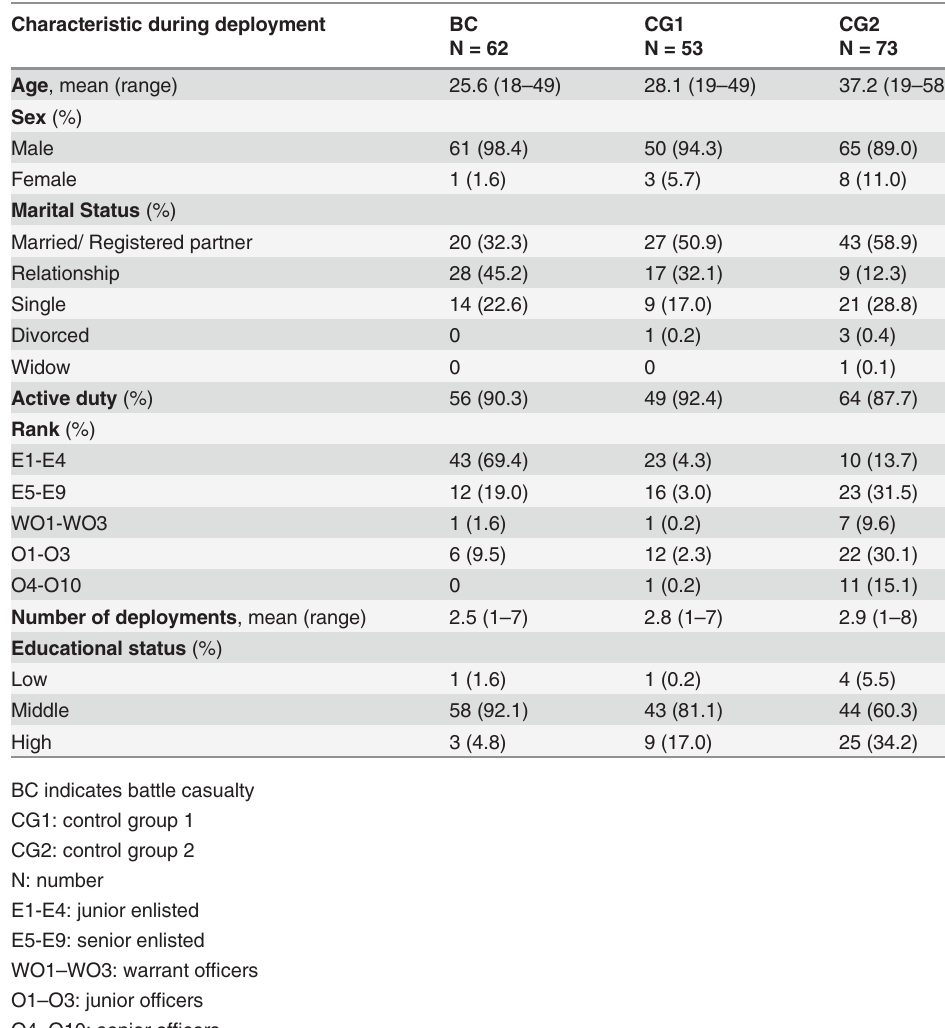
Table 2. Demographics of battle casualties and both control group. Characteristic during